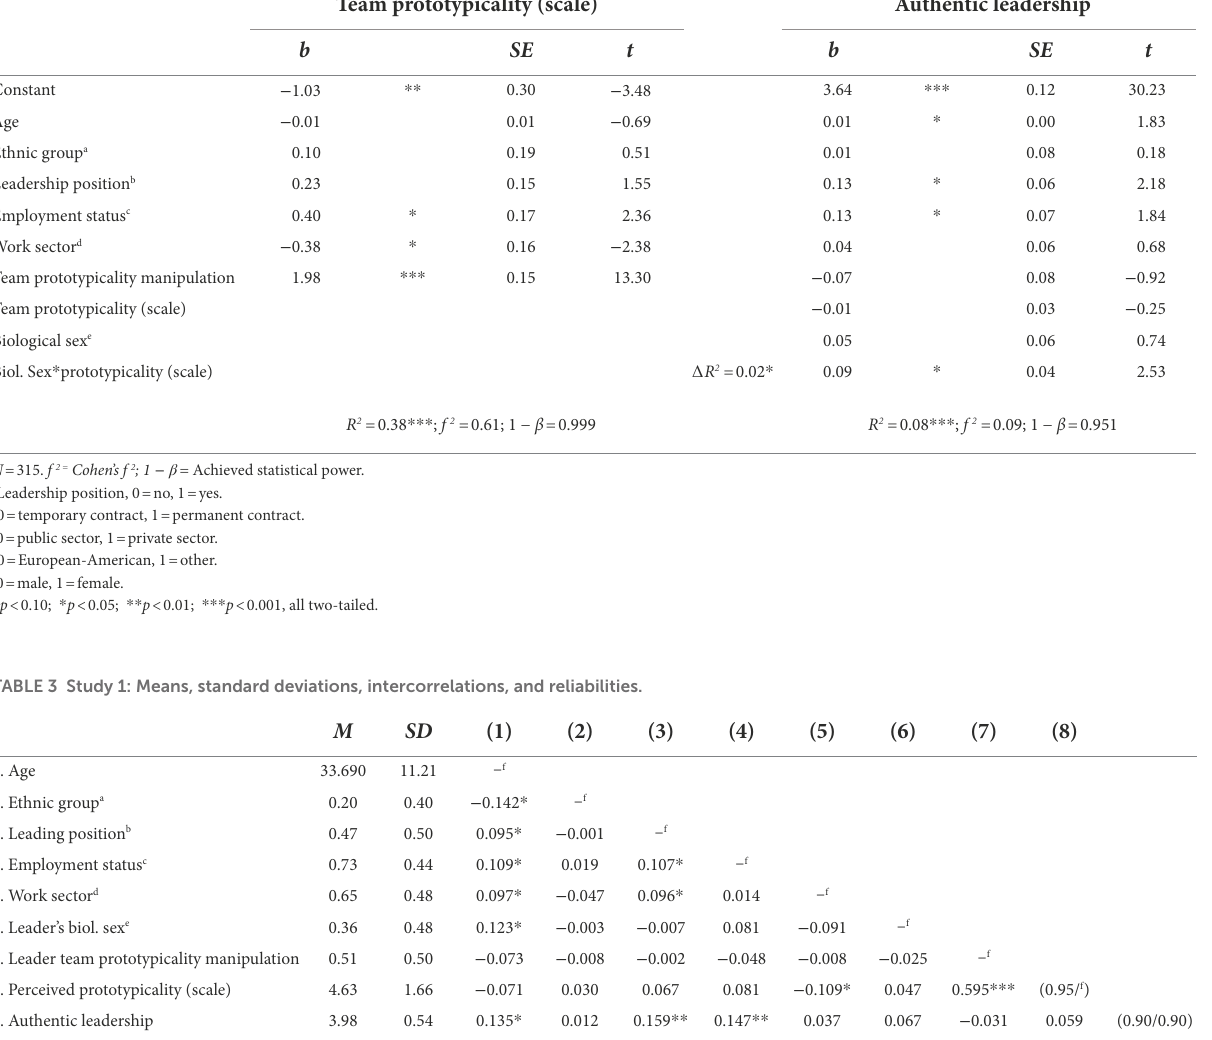
TABLE 2 Study 1: Results (manifest) with control variables (PROCESS model 14; 10.000 bootstrapping